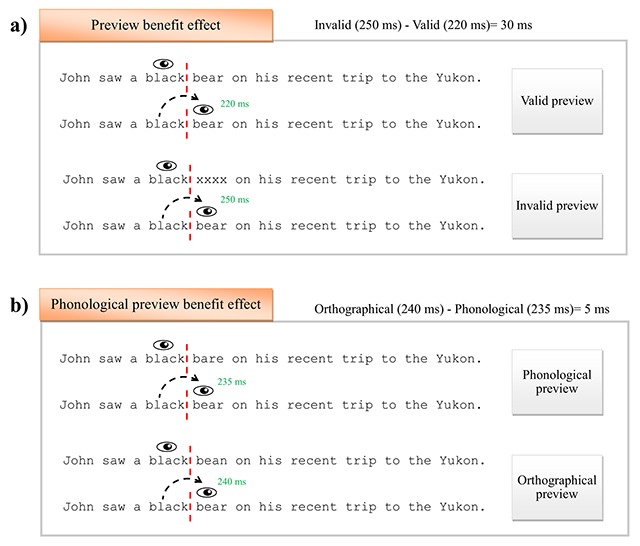
An illustration of the preview benefit (a) and phonological preview benefit (b) in English using the boundary technique (Rayner, 1975). The invisible boundary is illustrated with vertical dotted lines. In Chinese studies, the baseline for the phonological preview benefit effect is typically an unrelated-word preview (see the main text). In the classical preview benefit effect (panel a), different invalid preview masks can be used, e.g.: bear -> hurm (pseudoword), bear -> txvu (random letter mask), or bear -> tuna (unrelated word).